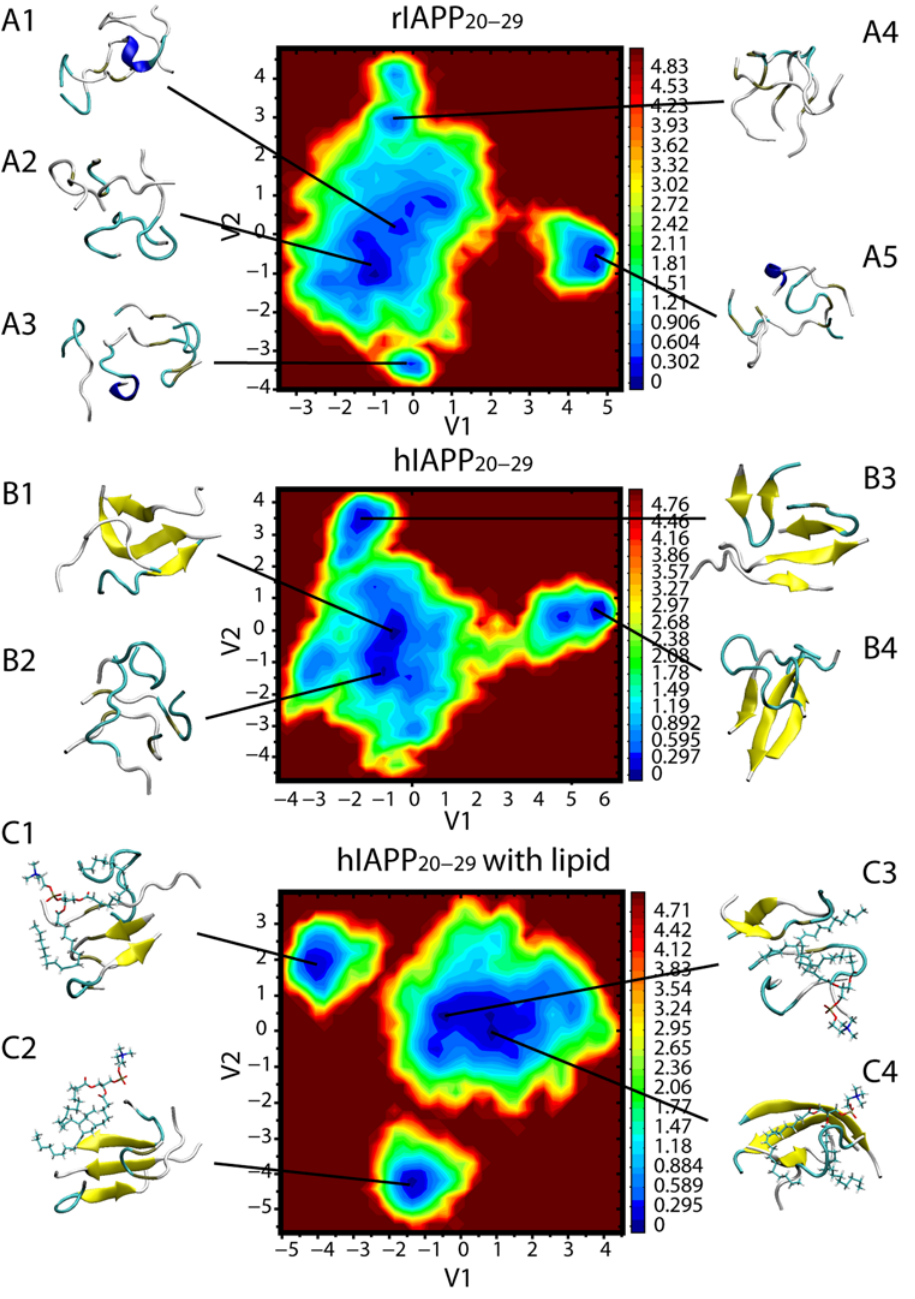
Figure 2. Free energy landscapes (in KJ/mol) of rIAPP, hIAPP, and hIAPP/lipid systems. The energy landscapes are constructed by dPCA method based on the last 80 ns ensemble from trajectories 0, 1, 2, and 3 (four trajectories under lowest temperatures) consisting of 320,000 structures in individual REMD simulations. The representative structures corresponding to each local minimum are plotted by VMD package [54]. Peptides are colored by different sorts of structures, including b -sheet (yellow), helix (blue), turn (cyan), and coil (white). Lipid molecules are